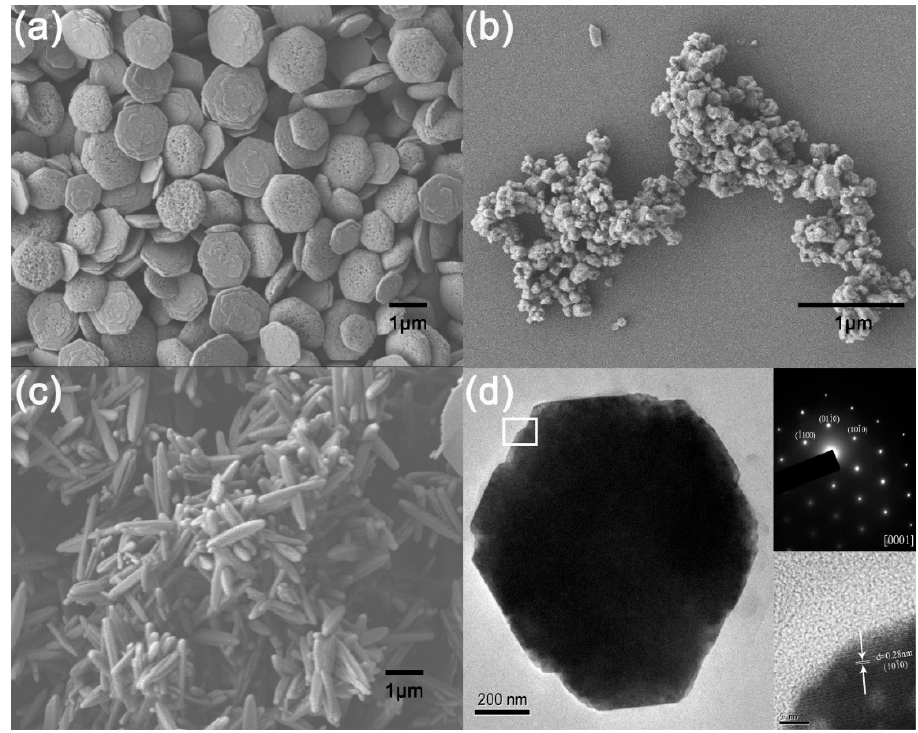
Figure 2. SEM images for all products and TEM image for ZnO-OS: ( a )ZnO-OS; ( b ) ZnO-TS; ( c ) ZnO-NC; and ( d )TEM and SAED images for ZnO-OS.